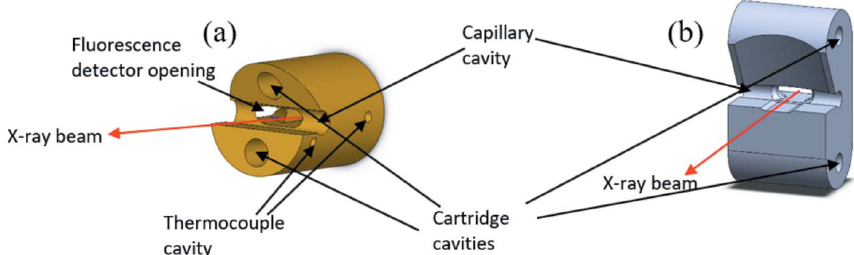
Figure 1 SolidWorks (https://www.solidworks.com/) drawings of the ( a ) in-line and ( b ) perpendicular SiC head